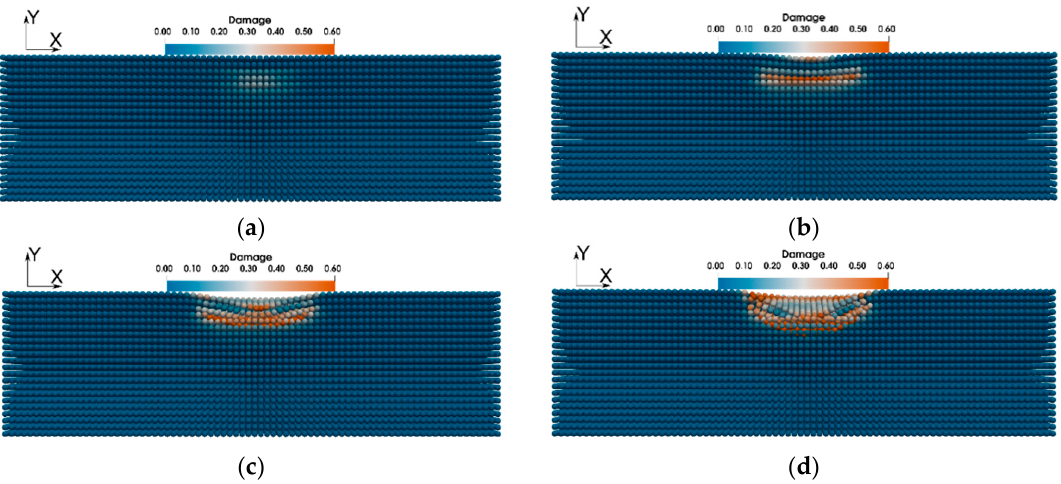
Figure 10. The cross-section (x-y plane) along the middle of the rail head in the longitudinal direction. Damage is shown in the top part of the model after: ( a ) 37,000; ( b ) 42,500; ( c ) 42,850; and ( d ) 42,884 cycles.